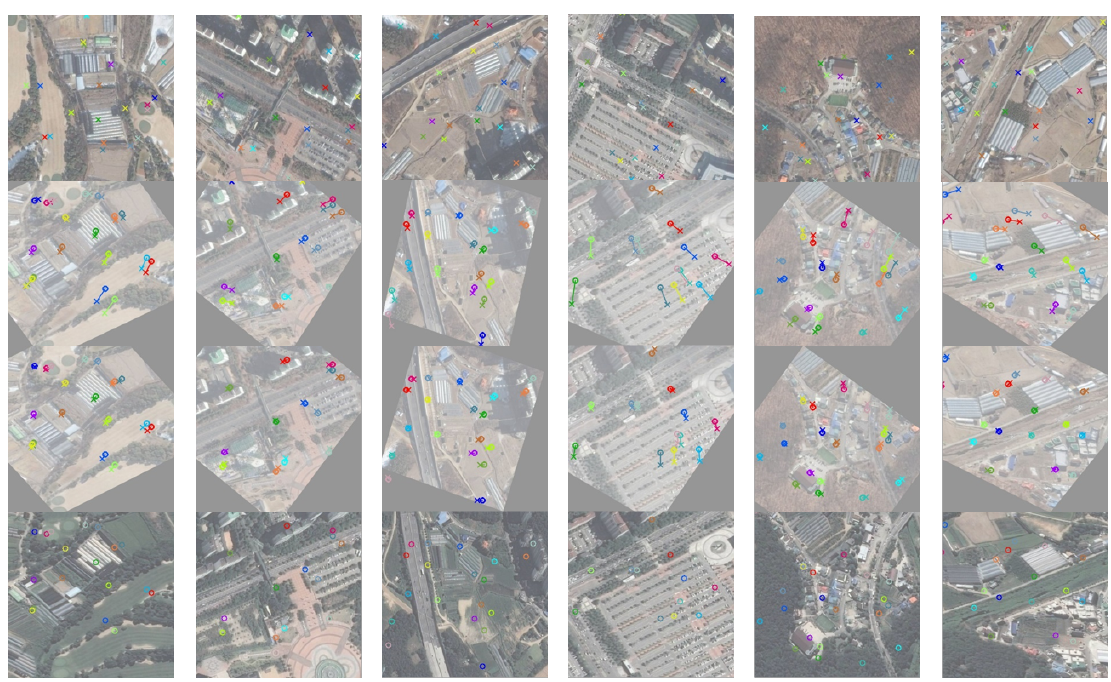
Figure 11. Visualization of the matched keypoints. Rows are each as follows: (1) source images, (2) results of CNNGeo [36], (3) results of our method, (4) target